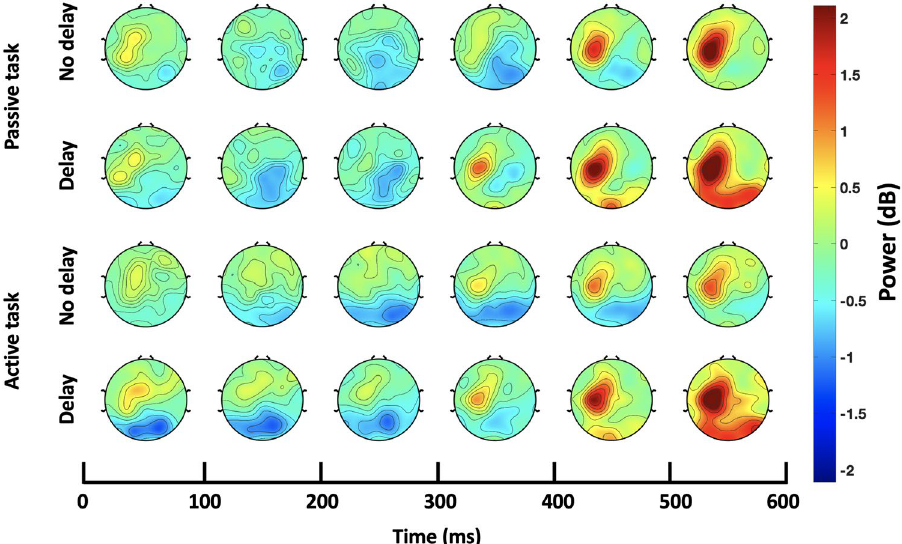
Figure 3. Time course of scalp topographies showing beta power during the passive and active tasks. The scalp topographies under the delayed and synchronous conditions are shown with a resolution of 100 ms. The onset at 0 ms corresponds to the haptic collision event. Beta rebound activation in the sensorimotor ROI is observed time-locked to the haptic collision event in both the passive and active